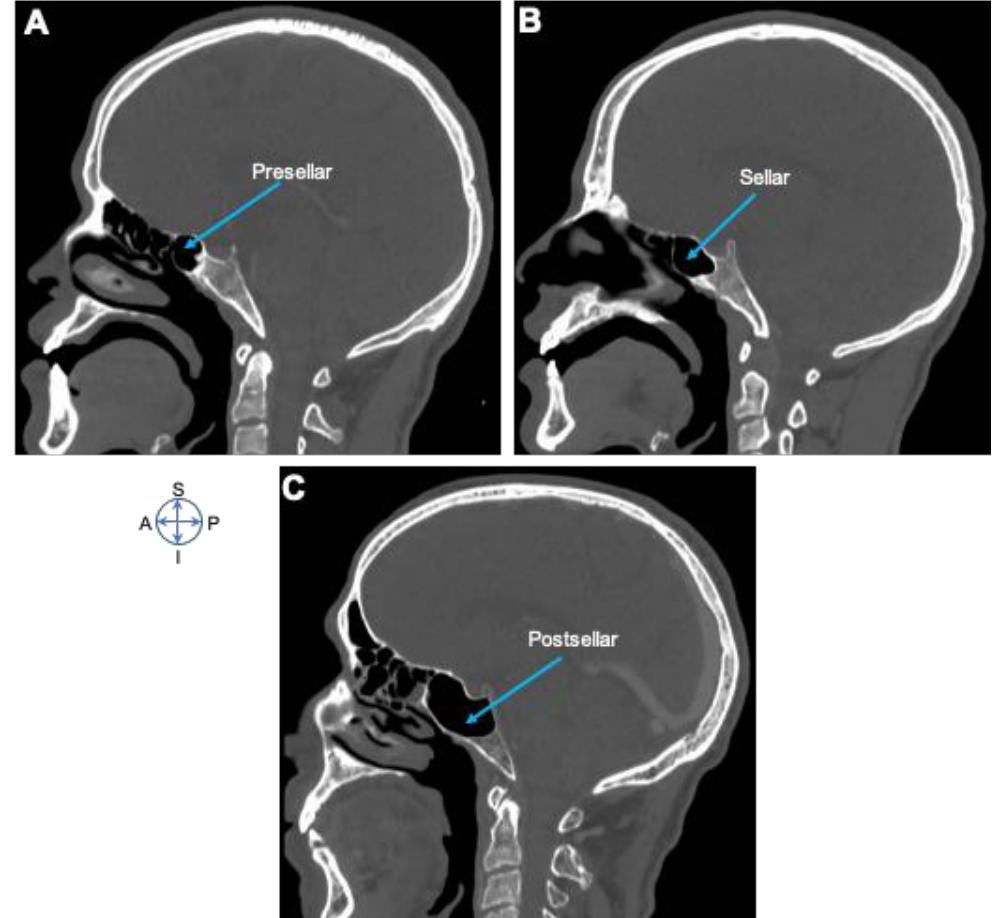
Figure 1. Anatomographic variants of sphenoid sinus. Sagittal CT images showing ( A ) presellar, ( B ) sellar, and ( C ) postsellar types of sphenoid sinus. Note that the sellar type of pneumatization was found to be the most frequent anatomographic variant of sphenoid sinus in the Ethiopian population. Image orientation: S, superior; I, inferior; A, anterior; P, posterior.